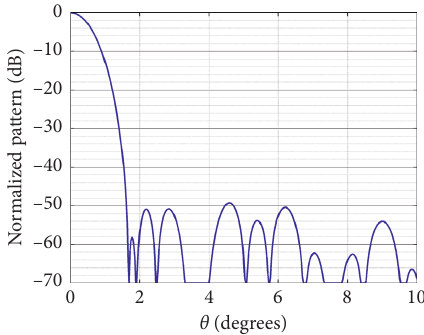
� 91, N � 75, and t r